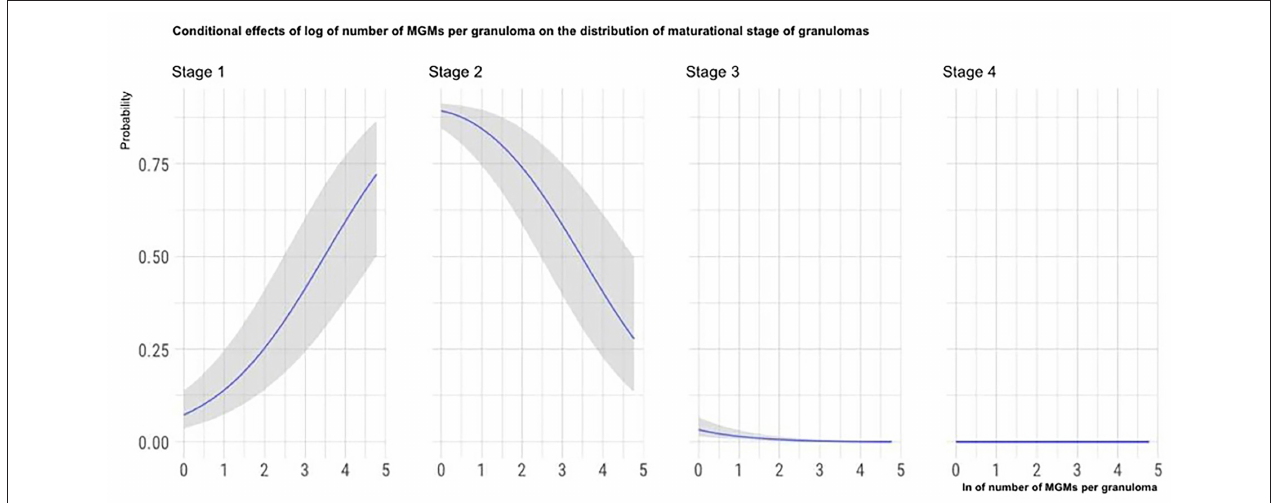
FIGURE 6 | Marginal effects of the number of MGMs per granuloma on granuloma histological stage. The figure shows that as the number of MGMs per granuloma increases, the possibility that granulomas are classified in the high histological stages